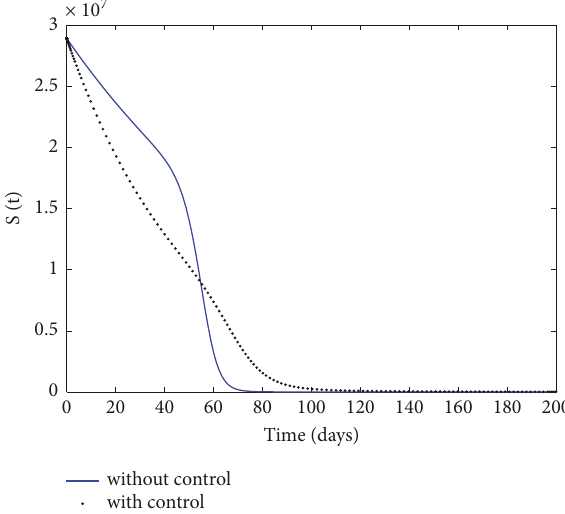
Figure 15: Behaviour of susceptible individuals with diabetes with and without lockdown control.